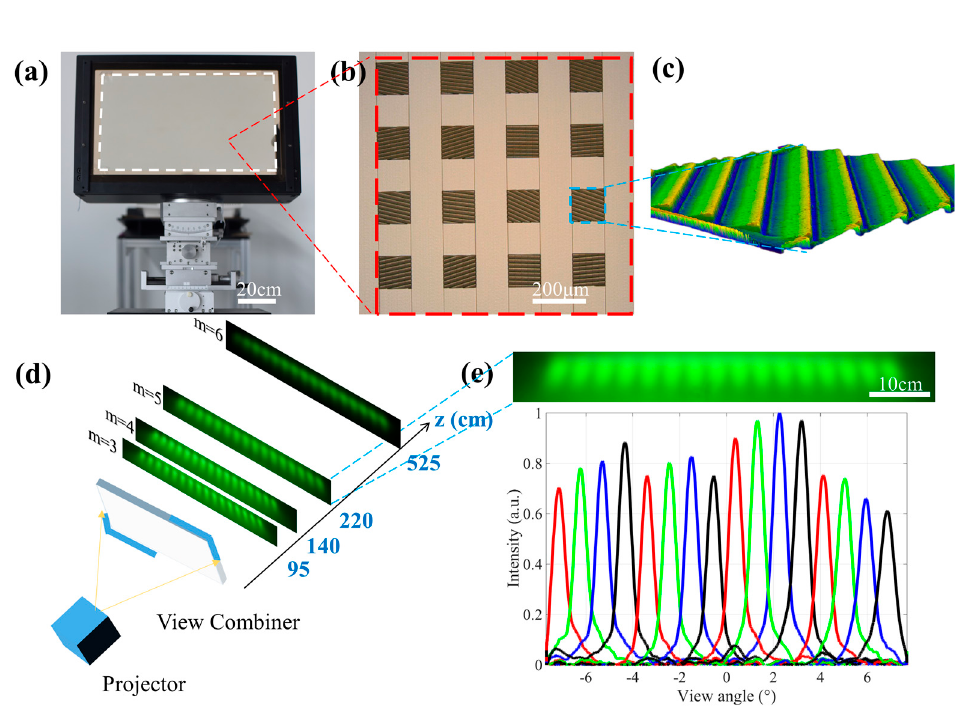
Figure 3. View combiner and its optical properties. ( a ) The photo of a 20-inch view combiner; ( b ) The microscopic picture of a voxel comprised of 4 × 4 pixels; ( c ) A 3D microscopic photo of a pixelated MBG, captured by a laser confocal microscope (LEXT, OLS4100, OLYMPUS, Tokyo, Japan). The artificial color indicates the structural variation in height; ( d ) The intensity distribution of 16 viewpoints at different viewing distances. The z-axis indicates the viewing distance before the view combiner; ( e ) The photo of 16 viewpoints at the fifth order diffraction and the intensity distribution curve of 1–16 viewpoints at the 5th order.